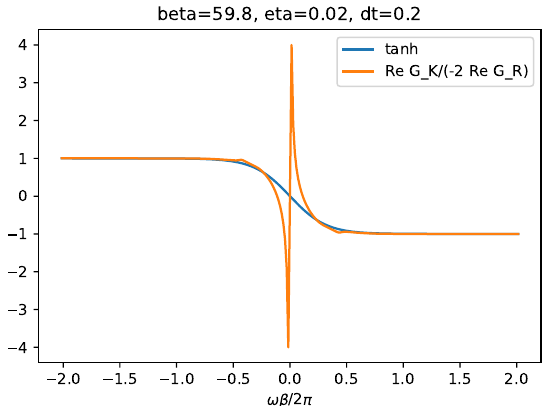
Figure 16 . The ratio (3.21) for G LR at η = 0 . 02 , dt = 0 . 2 , J = 0 . 5 , µ = 0 . 05 extracted from the real-time